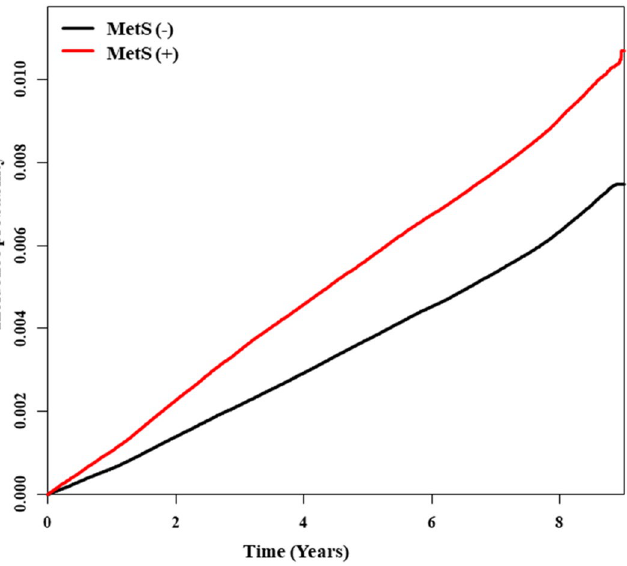
Figure 3. Incidence of OSA over the 10-year follow up period between MetS and non-MetS patients (log-rank test, p < 0.0001).